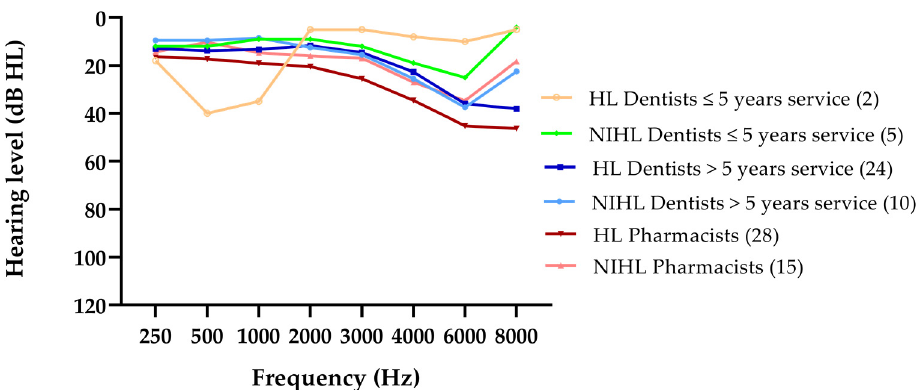
Figure 1. The two main patterns of audiometric hearing thresholds, NIHL and HL, for the two groups of dentists and the controls. For NIHL, the audiometric pattern had to adhere to the following 3 requirements: (1) a decrease in threshold of at least 20 dB HL at 3000, 4000, and/or 6000 Hz, (2) an HL at these frequencies greater than the age-related norm value, and (3) at least 10 dB HL poorer than the threshold at 8000 Hz. HL was defined as hearing thresholds above 20 dB HL at one or more frequencies between 250 and 8000 Hz. The number of ears is mentioned between brackets.